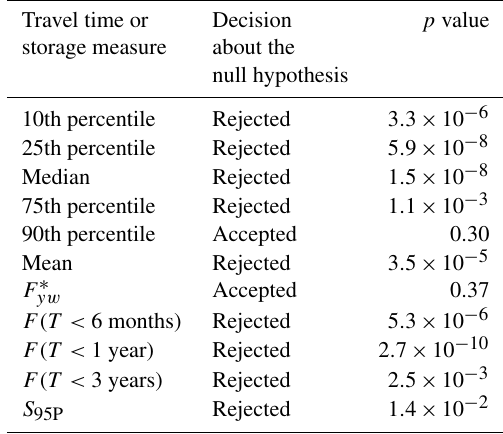
Table B1. Results from the Wilcoxon rank sum test comparing the travel time and storage measures between 2 H and 3 H behavioral so- lutions. The null hypothesis is that the measures are extracted from the same underlying distribution for both tracers. Travel time